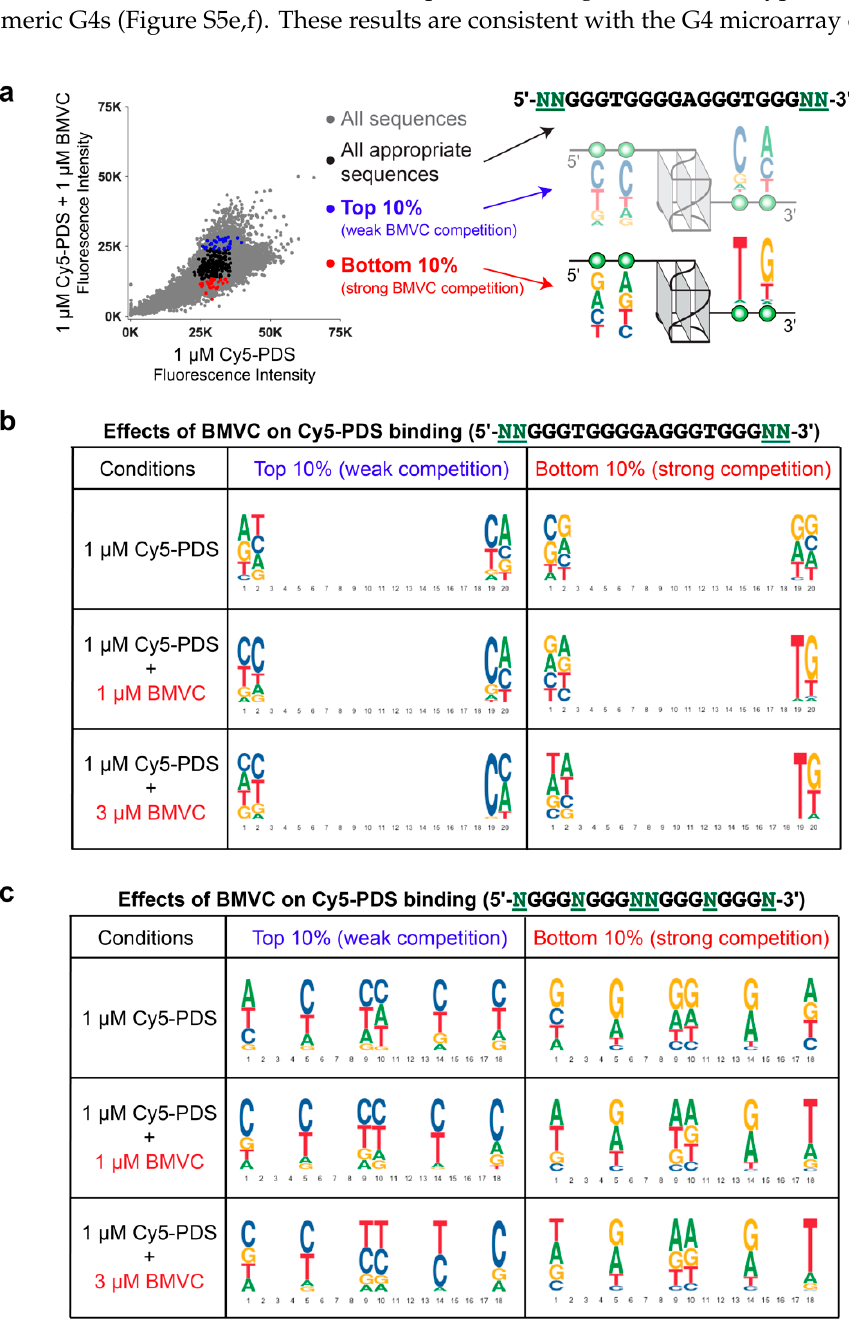
Figure 3. The binding selectivity of BMVC for the flanking sequences of MYC G4. ( a ) An illustration of binding logo analysis for Cy5-PDS signal with the competition of 1 µM BMVC on MYC G4-derived sequences 5 ′ -NNGGGTGGGGAGGGTGGGNN-3 ′ (256 total sequences). ( b ) The inhibitory effects of BMVC on the binding of Cy5-PDS to MYC G4-derived sequences with variant 5 ′ - and 3 ′ - flanking segments (5 ′ -NNGGGTGGGGAGGGTGGGNN-3 ′ ). ( c ) The inhibitory effects of BMVC on the binding of Cy5-PDS to MYC G4-derived sequences 5 ′ -NGGGNGGGNNGGGNGGGN-3 ′ , (4096 total sequences), which include all possible loop and flanking variants.